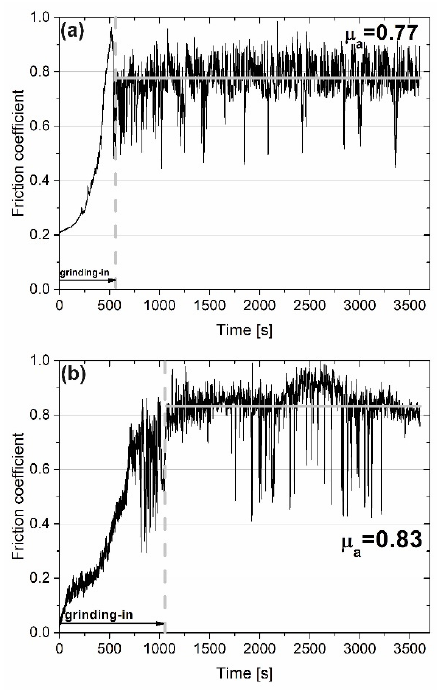
Figure 2. Results of wear test conducted at room temperature for sintered Ni-50%NiCr(80/20) ( a ) and Ni-40%NiCr(80/20)-20%CaF 2 ( b ) (friction coefficient vs. time of friction).